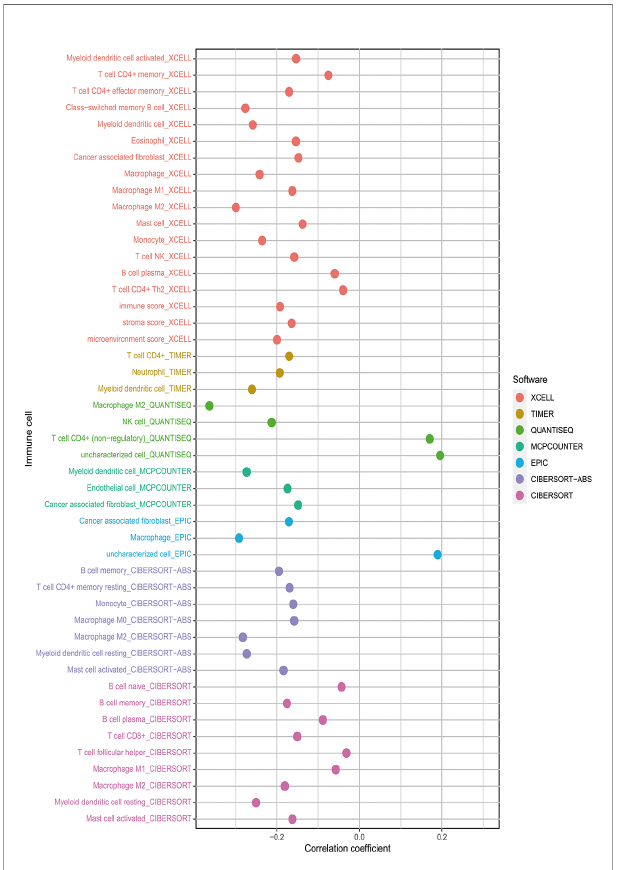
FIGURE 7 | The risk score was negatively associated with most tumor- in fi ltrating immune cells shown by Spearman correlation analysis in current acknowledged methods such as XCELL, TIMER, QUANTISEQ, MCPcounter, EPIC, CIBERSORT-ABS, and